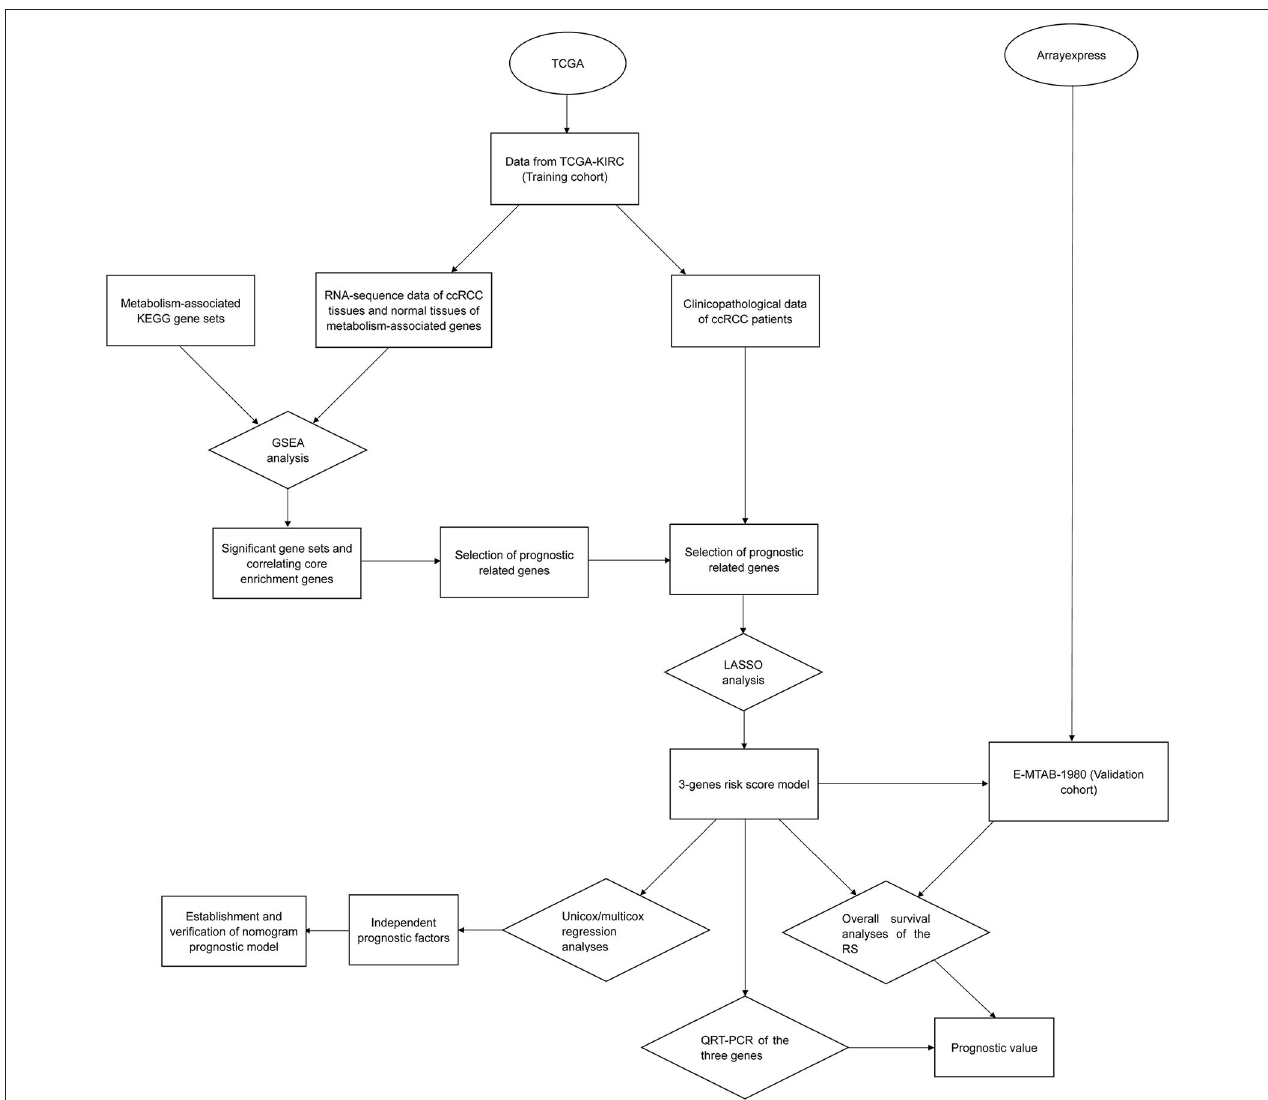
FIGURE 1 | Overall workflow of the study design and analysis.